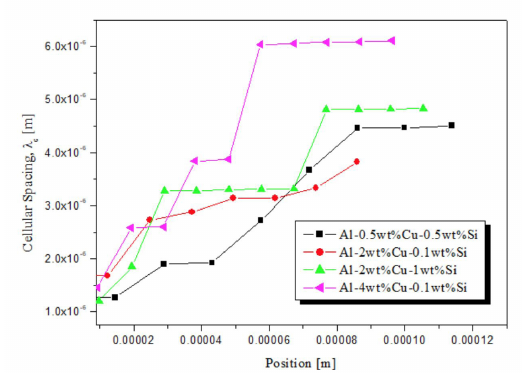
) as a function of position for: Al- Figure 6. Cellular spacing (λ C 0.5wt%Cu-0.5wt%Si, Al-2.0wt%Cu-0.1wt%Si,